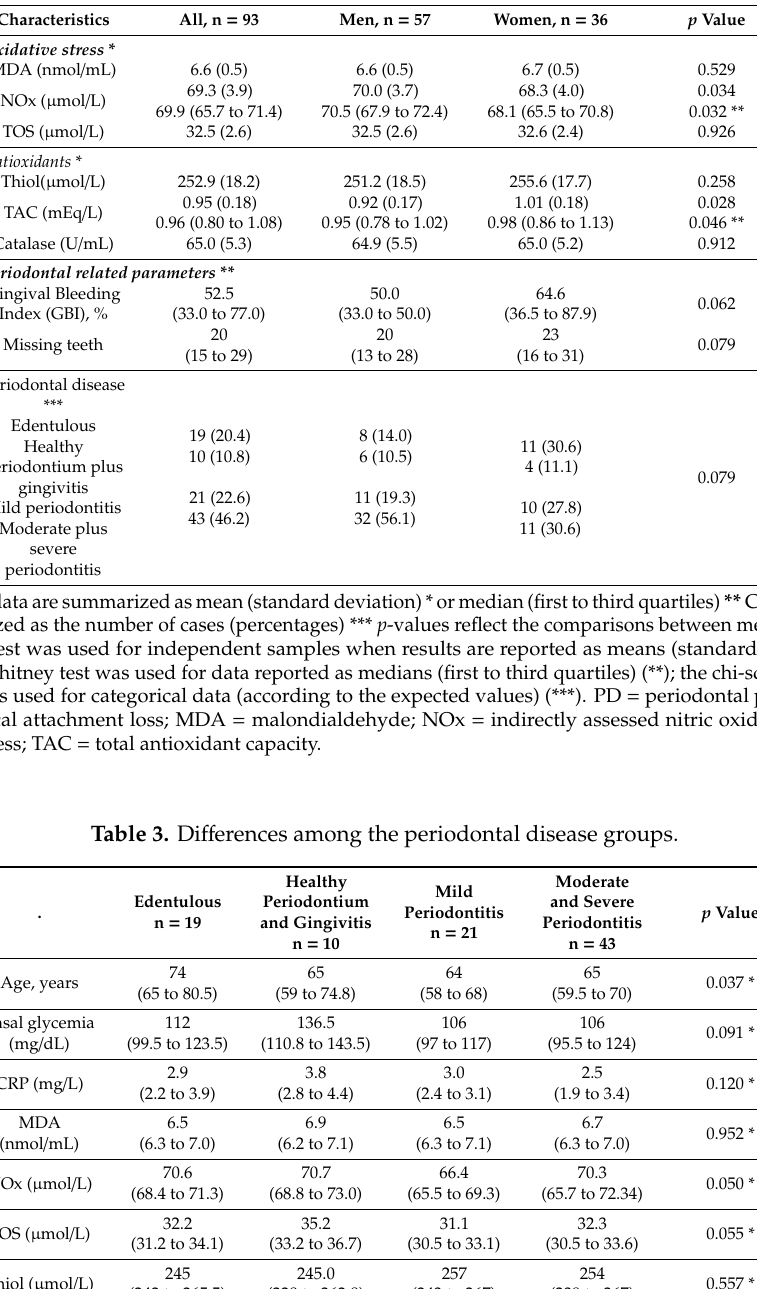
Table 2. Oxidative stress biomarkers and periodontal disease-related characteristics.